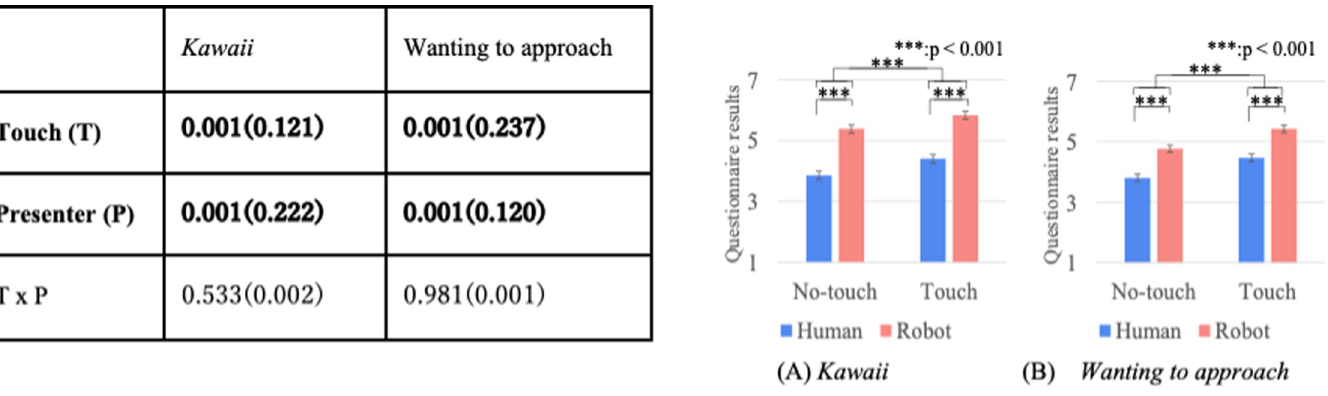
Fig 10. Perceived presenter’s feelings of kawaii and wanting to approach